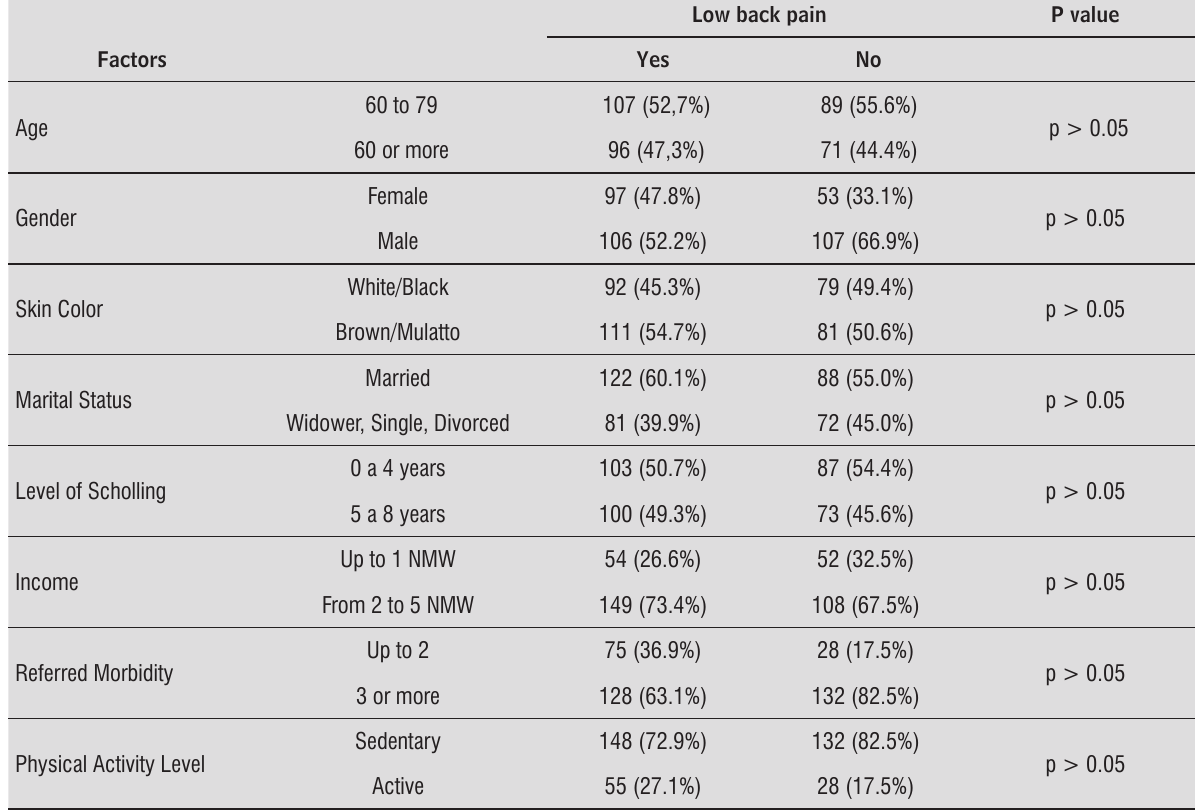
Low back pain P value